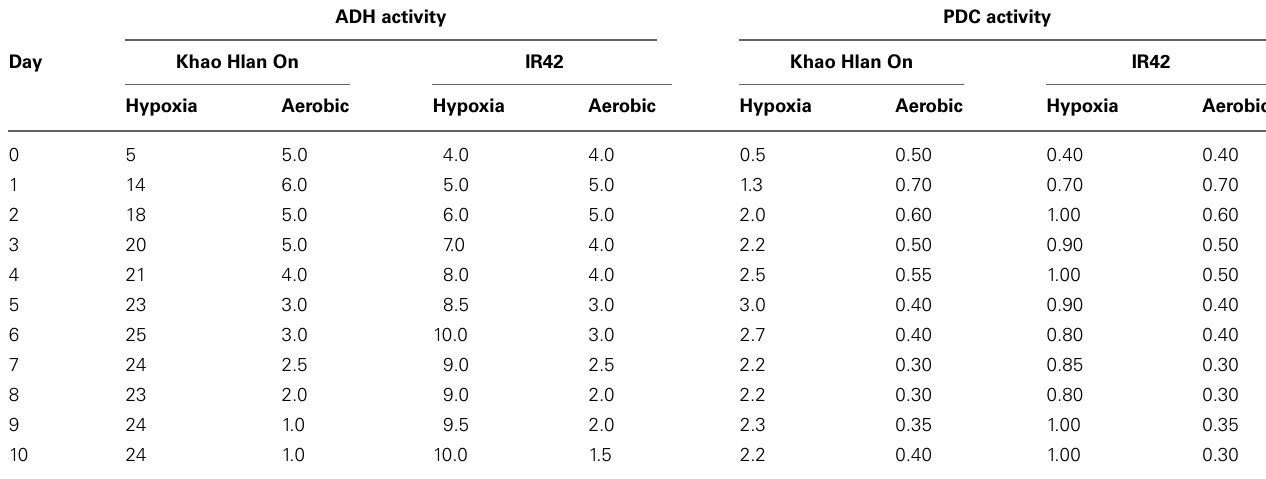
Table 2 | Activities (units min − 1 mg − 1 protein) of alcohol dehydrogenase (ADH) and pyruvate decarboxylase (PDC) enzymes in the tolerant “Khao Hlan On” and the sensitive “IR42” from day 0 (dry seeds) to day 10 under aerobic conditions and under 10cm of submergence (hypoxia) in